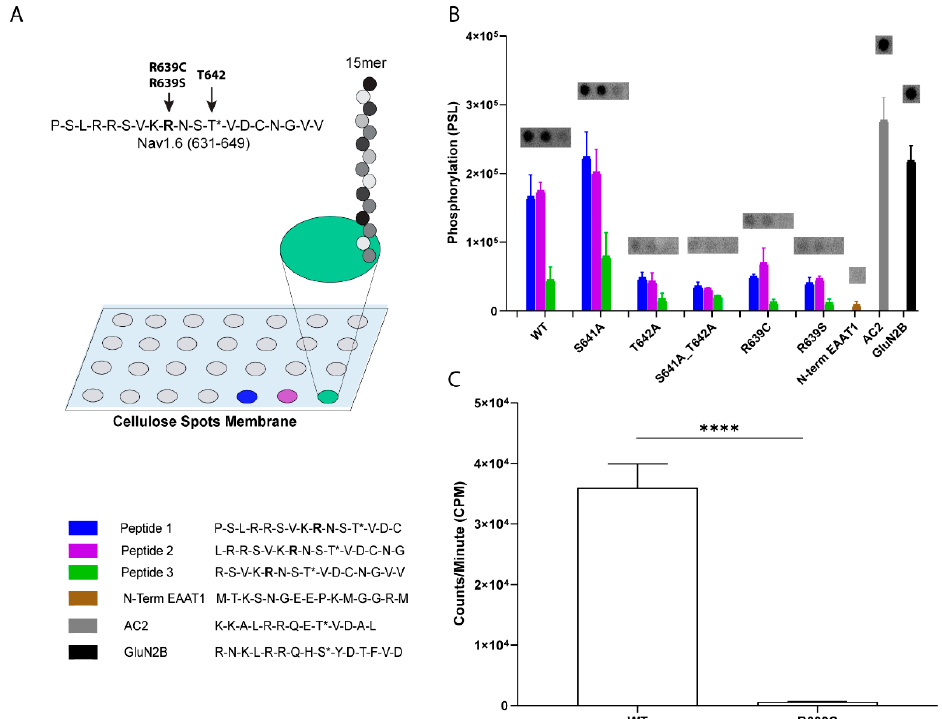
Figure 5. R639C reduces CaMKII-dependent phosphorylation of key modulatory site, T642. ( A ) Schematic of the Spots immobilized peptide tiling assay performed in ( B ). ( B ) Average phosphorylation intensity of immobilized WT peptides tiled from amino acids spanning 631–649 (Peptides 1–3) after α CaMKII phosphorylation in the presence of [ γ - 32 P]-ATP. Mutant peptides included Ala substitution for Thr/Ser, and Cys or Ser replacement for R639. ( C ) Average phosphorylation intensity of soluble peptides WT (RSVKRNSTVDCNGVV) and R639C (RSVKCNSTVDCNGVV) after α CaMKII phosphorylation in the presence of [ γ - 32 P]-ATP. R639C (as well as R639S) ablates phosphorylation at T642 in both immobilized and soluble kinase assays. The N-terminus of EAAT1 served as the negative control; AC2 and GluN2B phosphorylation served as positive controls. **** p < 0.0001; n = 3. Student’s t -test ± SEM (error bars). The * (asterisks) in the key (bottom left panel) indicate a CaMKII phosphorylation